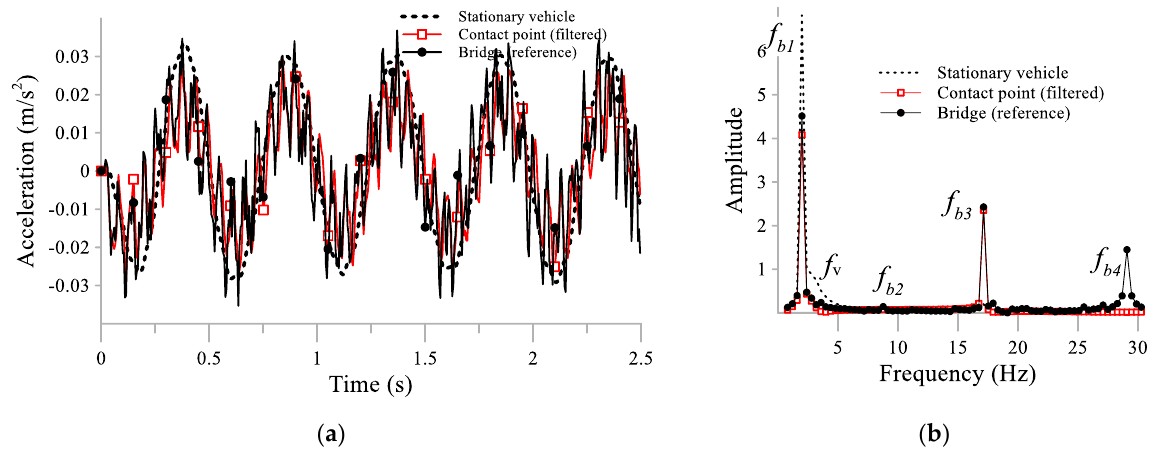
Figure 10. Dynamic response of damped stationary vehicle with a filtered contact-point and the bridge ( a ) acceleration response at a mid-span location, along with ( b ) the acceleration spectra.